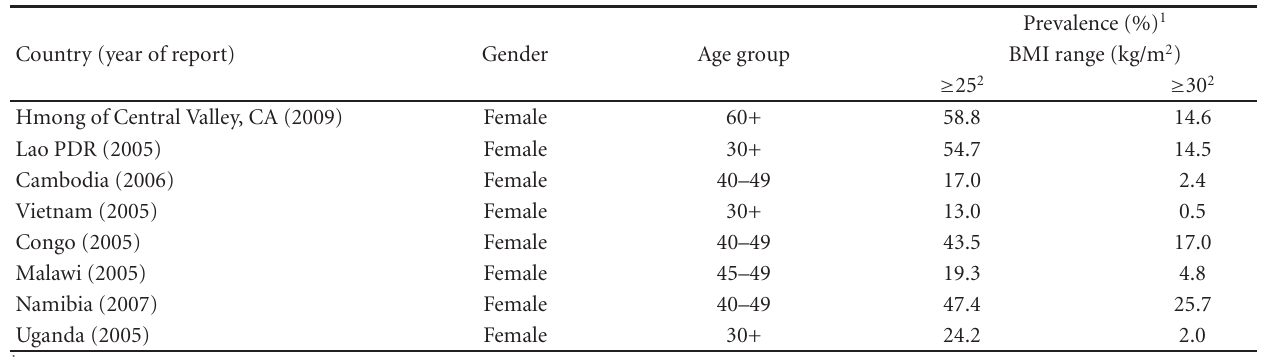
Table 5: Prevalence of excess body mass among Lao immigrants (California) and in several countries of Asia and Africa.